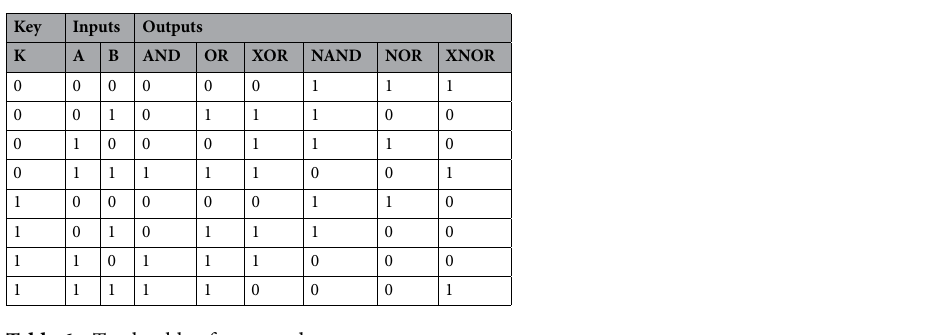
Table 6. Truth table of proposed